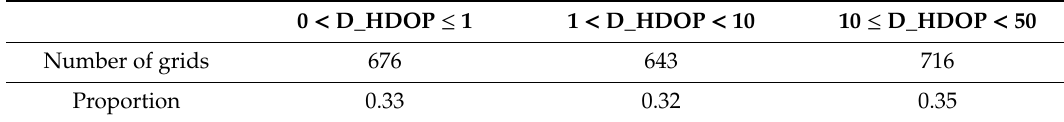
Table 8. Number of grids for the di ff erence of HDOP (D_HDOP).